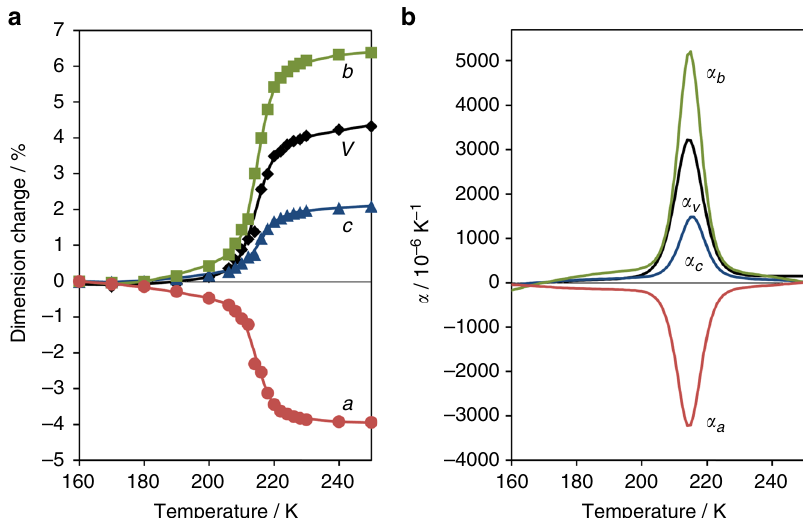
Fig. 4 Temperature-dependence on the structure of [Fe 0.84 Ni 0.16 ]. a Lattice parameters ( markers represent data; line represents fi tted model): a, b, c and volume. b Thermal expansion coef fi cients (from model), α : for a, b, c and volume